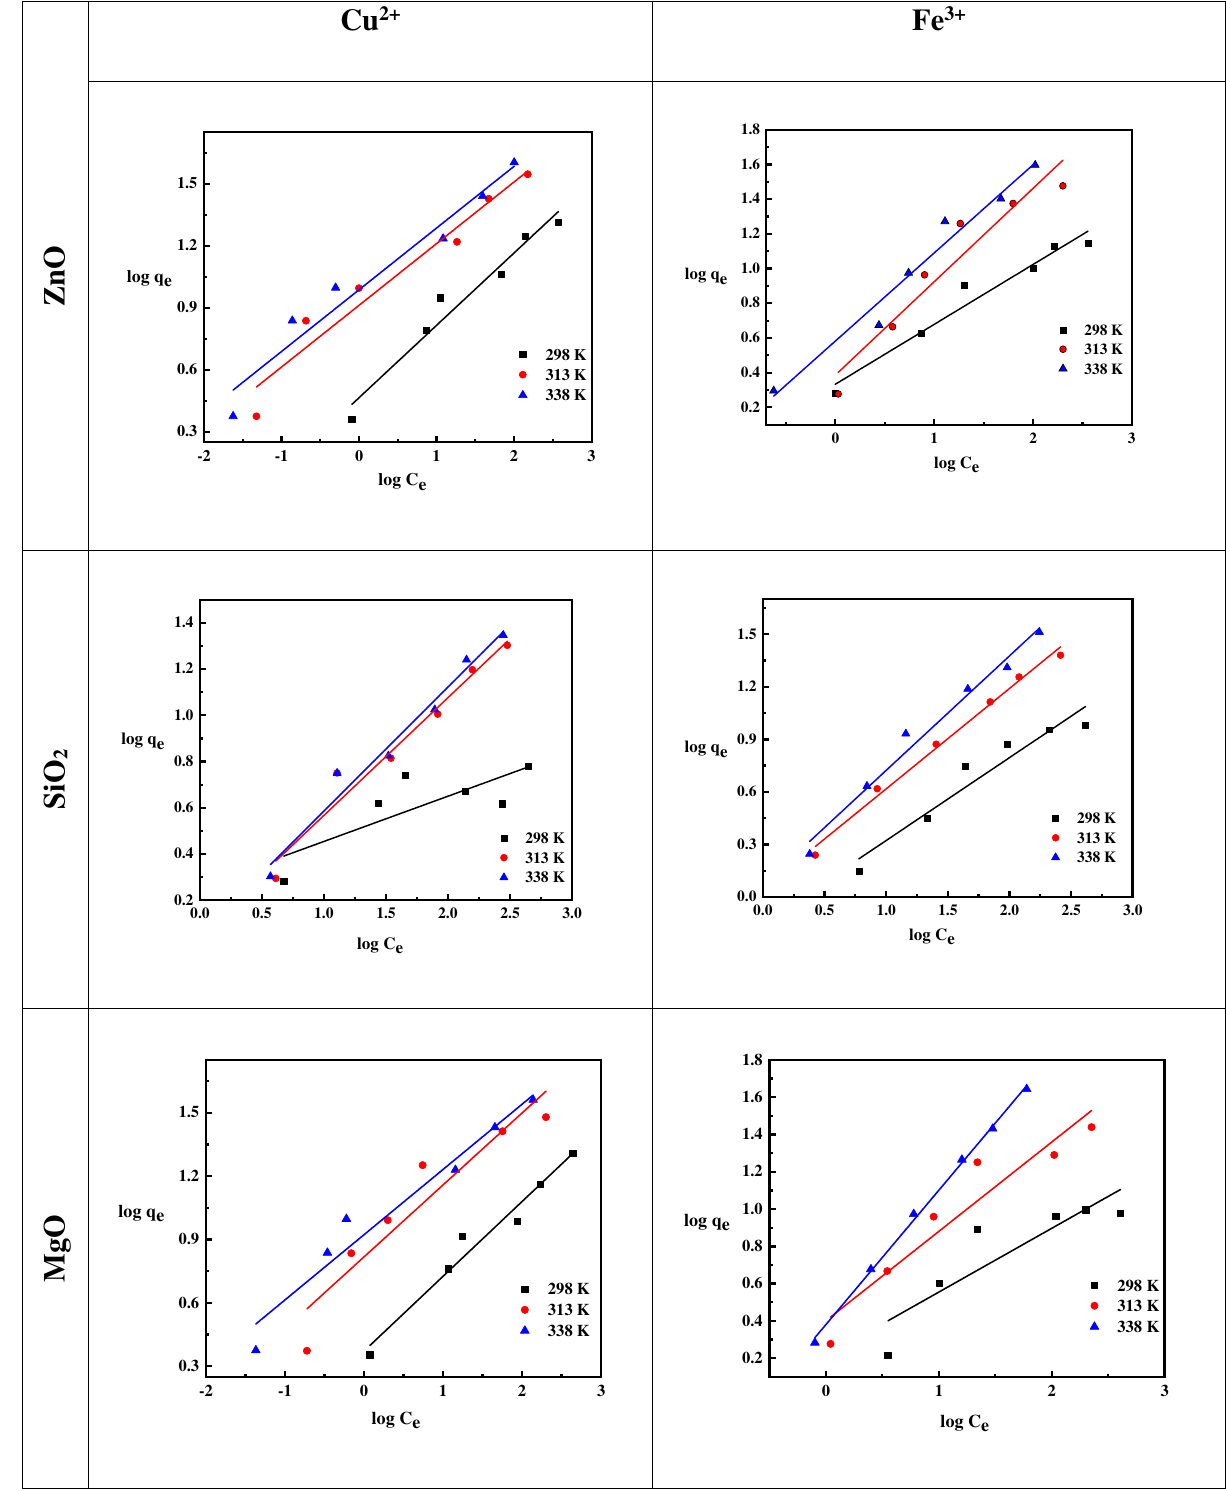
Figure 6. Linearized Freundlich isotherms for Cu 2+ and Fe 3+ ions adsorption on ZnO, MgO, and SiO 2 NPs at different